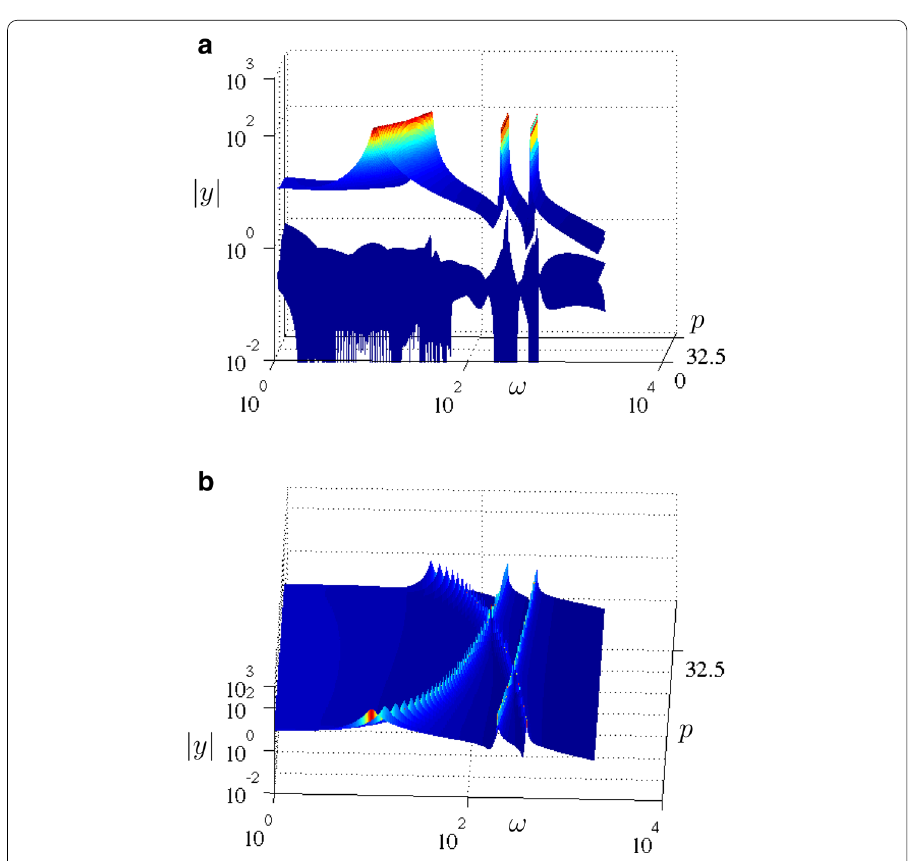
Fig. 12 Interpolation between ROMs of different types. a Interpolation between a BT ROM and an ssest ROM (with matched poles): response surfaces and the absolute errors. b Interpolation between a BT ROM and an ssest ROM (with mismatched poles): response